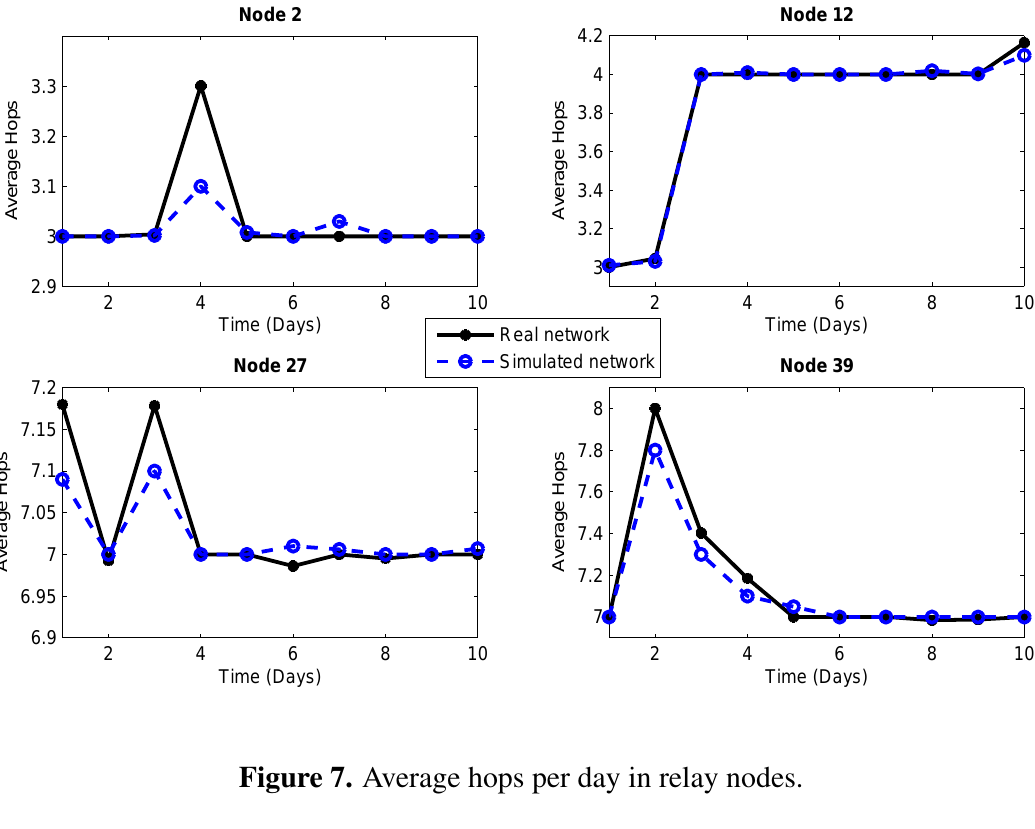
Figure 6. Average hops per day in source nodes.